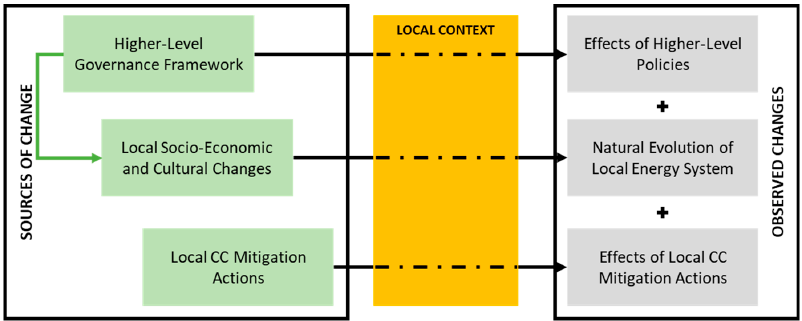
Figure 2. Framework of the sources of change and the observed changes in local GHG emissions.